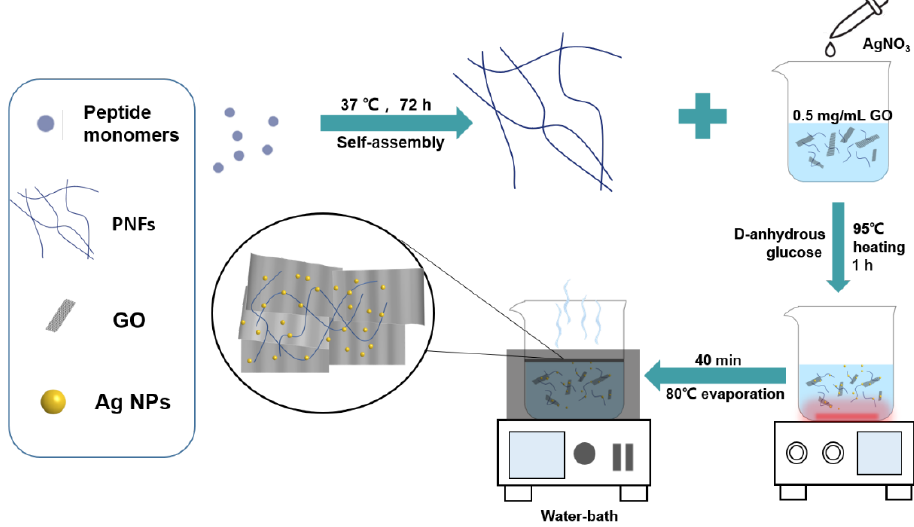
Scheme 1. Schematic presentation of the synthesis of GO/PNF/AgNP hybrid